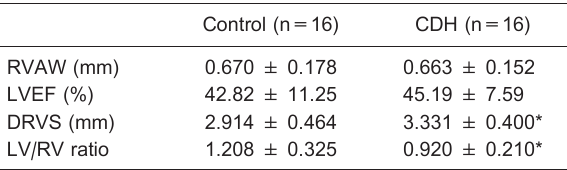
Data are reported as means±SD. RVAW: right ventricle anterior wall; LVEF: left ventricle ejection fration; DRVS: diastolic right ventricle size; LV/RV ratio: left ventricle/right ventricle ratio. *P , 0.007, compared to control (Student’s t -test).